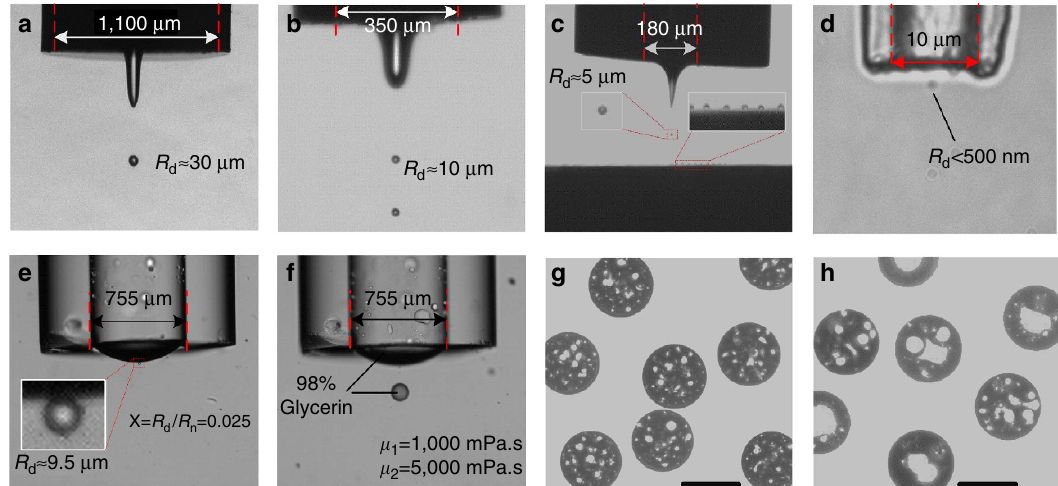
Figure 2 | Dispensed droplets and microcapsules. ( a – f ) Dispensing droplets from orifices with different radii shown in the panel. ( g , h ) Microcapsules obtained by dispensing silicon oil-in-water emulsion. Scale bars in g and h , 100 and 30 m m, respectively. NATURE COMMUNICATIONS|7:12424|DOI: